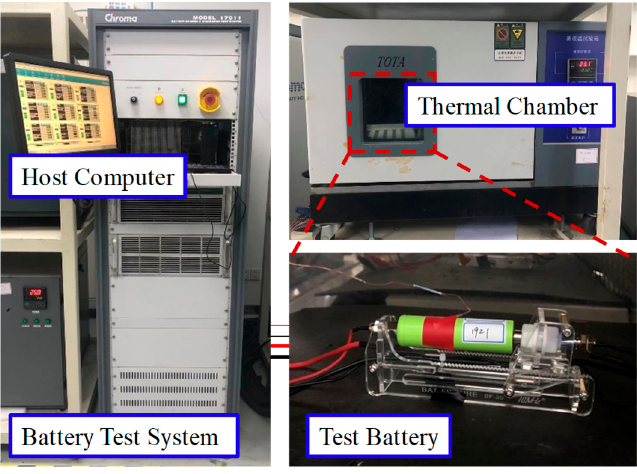
Figure 1. Experiment setups.